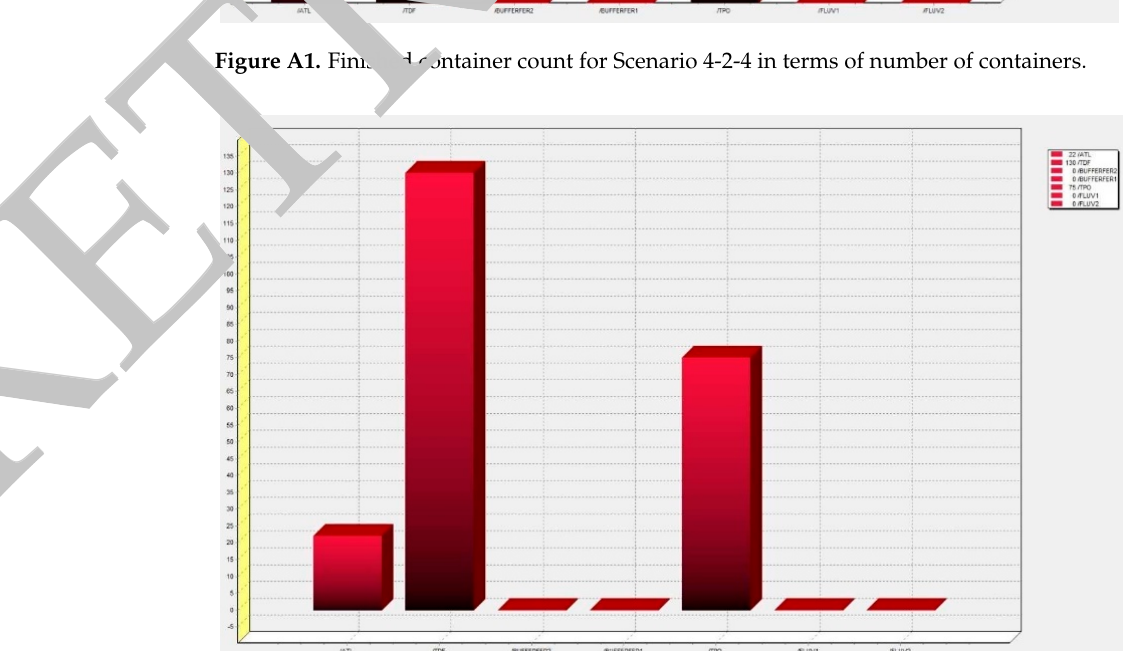
Figure A3. Rate of use of the two railway gantries of the multimodal terminal for Scenario 4-2-4.